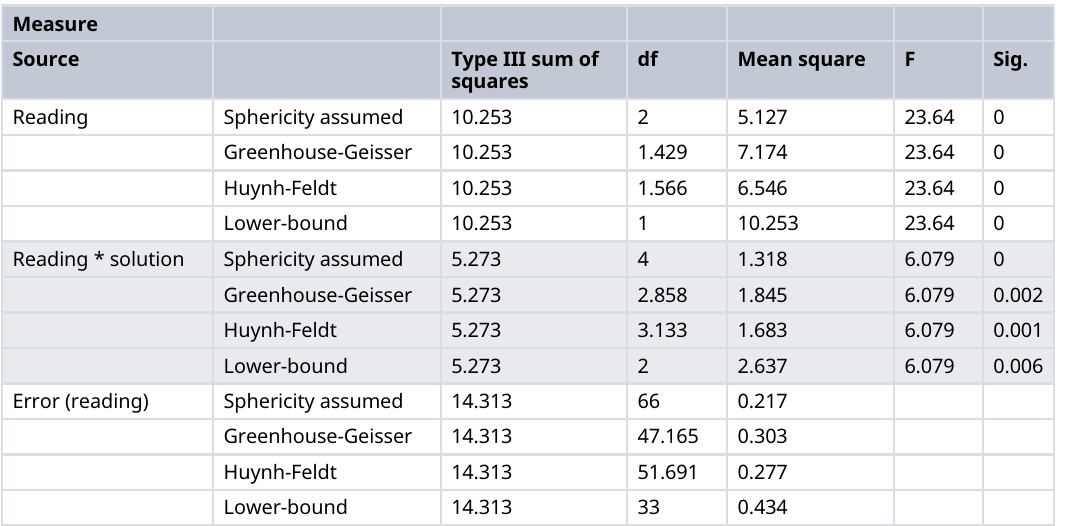
Table 1. Tests of within-subject